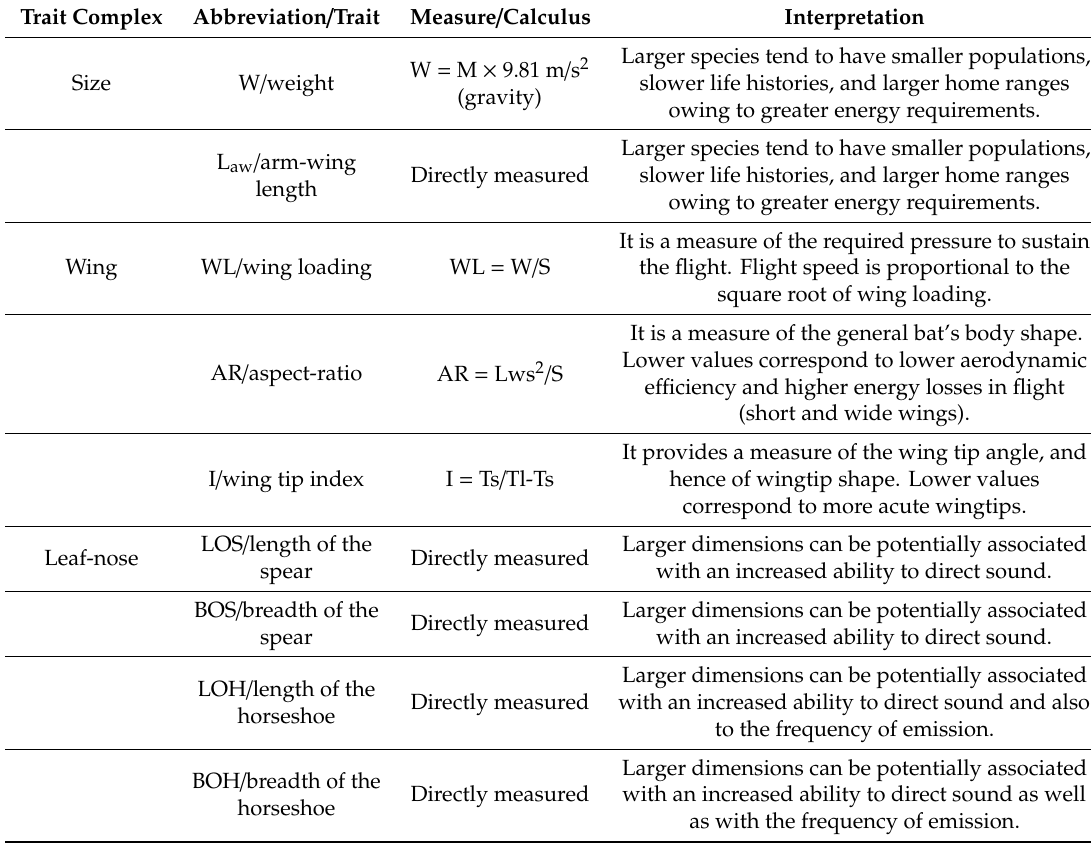
Table 1. Functional traits measured or calculated for captured individuals. Trait